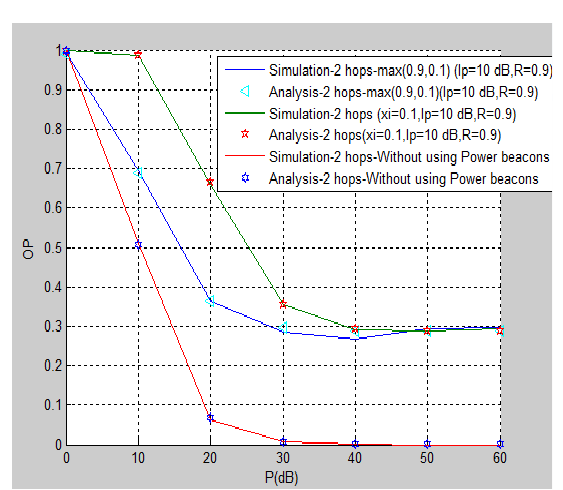
Fig. 5. OP versus P (dB): K=2, ( x PU , y PU )=(1, 1), R=0. 9